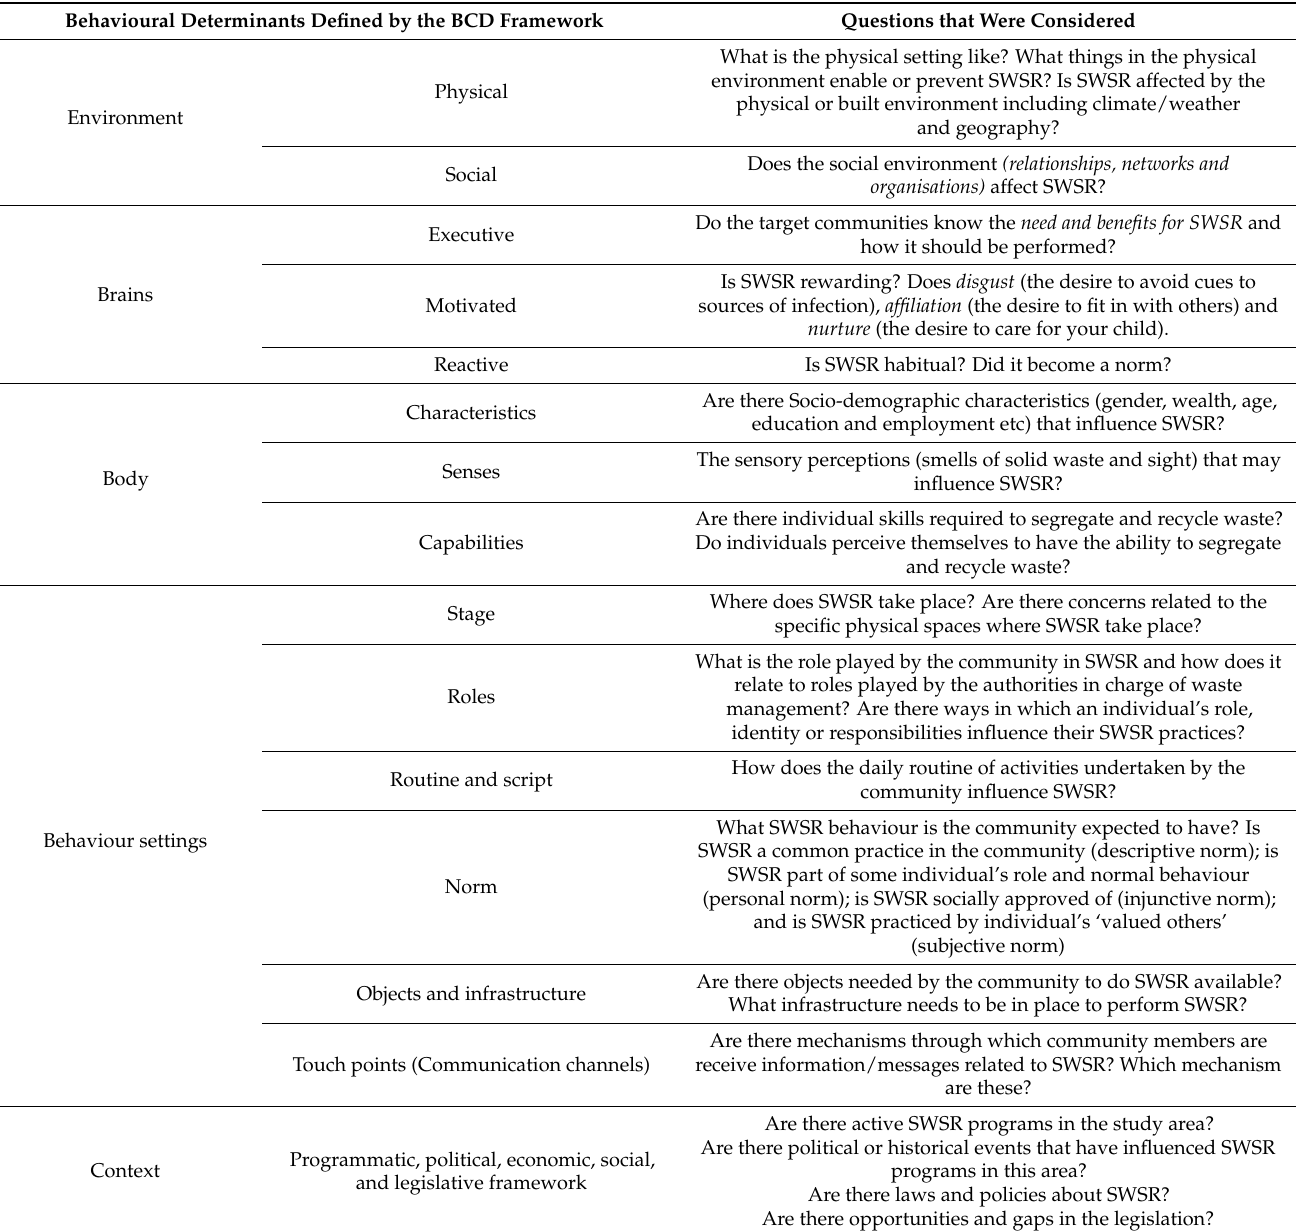
Table 1. Definitions of solid waste segregation and recycling determinants adapted from the Behavior centered design checklist